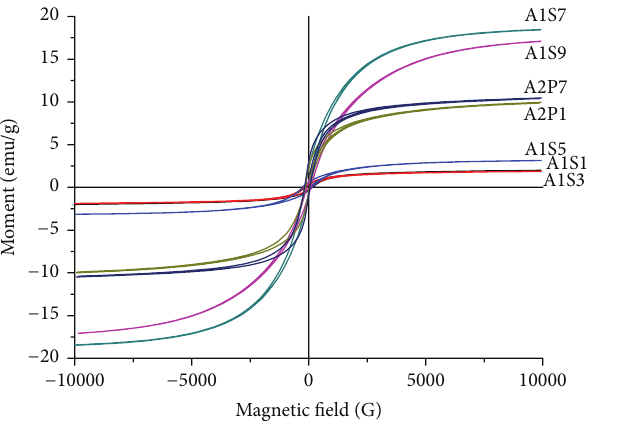
Figure 4: 𝑀 - 𝐻 curves of the glass ceramic samples with different chemical composition.